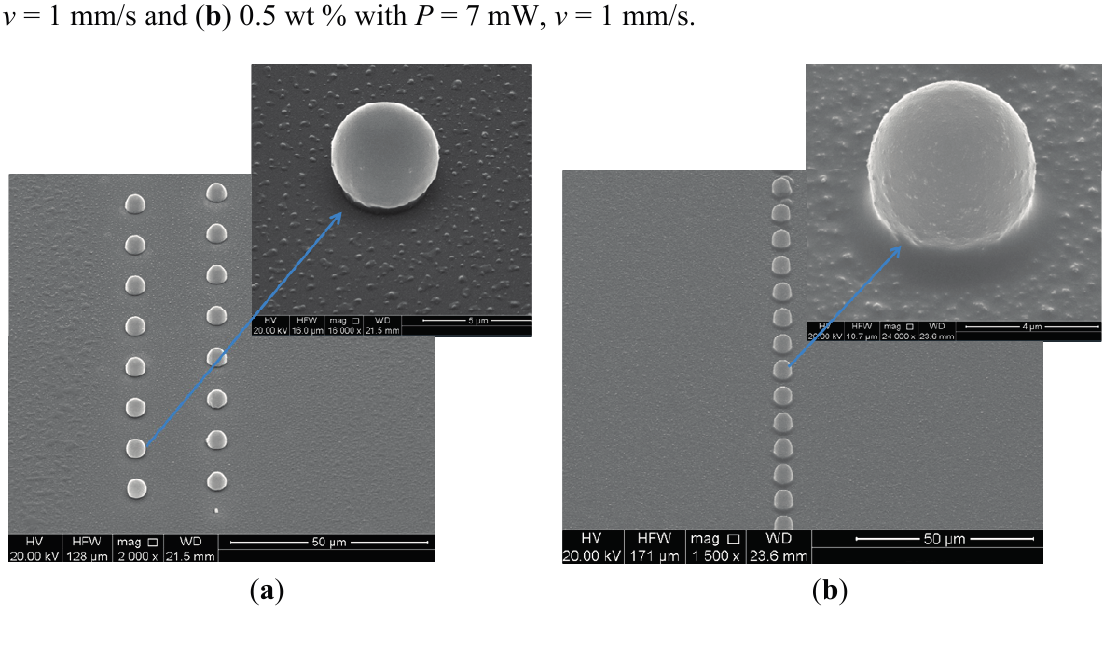
Figure 14. SEM images of 2PP ex situ prepared structures at ( a ) 0.001 wt % with P = 10